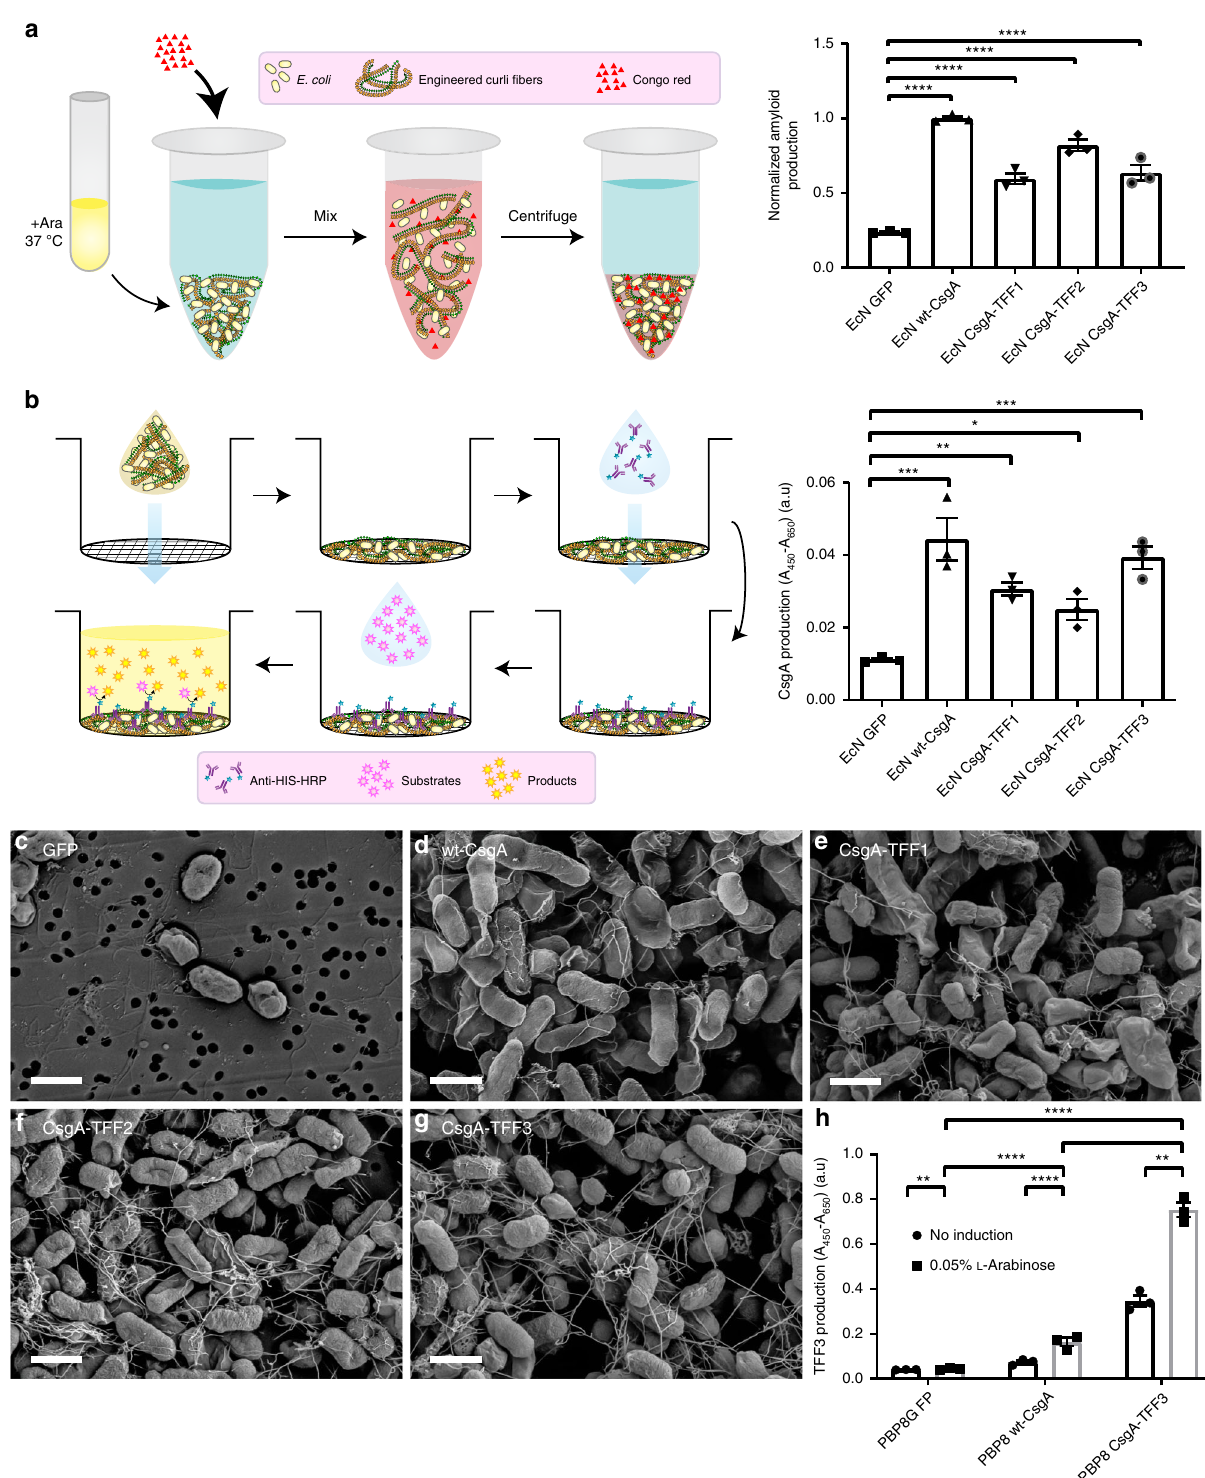
Fig. 2 Production of curli fi ber variants from engineered EcN. a Schematic of quantitative Congo Red (CR)-binding assay (Yellow ovals = E. coli , Orange and green lines = engineered curli fi bers, Red triangles = Congo Red) (left). Normalized amyloid production of each EcN variant, as measured by CR- binding assay (right), after induction with arabinose (Ara) at 37 °C in LB media. b Schematic of whole-cell fi ltration ELISA for the monitoring of modi fi ed curli production from bacterial culture (Purple Y shapes with blue dots = Anti-HIS-HRP, Pink stars = HRP Substrates, Yellow stars = HRP products) (left). Relative CsgA production between EcN variants, derived from anti-6xHis antibody-based detection. c – g Scanning electron micrographs of EcN transformed with plasmids encoding various proteins: c GFP d wt-CsgA e CsgA-TFF1 f CsgA-TFF2 g CsgA-TFF3 (scale bar = 1 μ m). h Relative TFF3 production (using anti-TFF3 antibody) of induced and non-induced PBP8 library. Data are represented as mean ± standard error of the mean (SEM). (ns) p > 0.05, * p ≤ 0.05, ** p ≤ 0.01, *** p ≤ 0.001, **** p ≤ 0.0001, one-way ANOVA followed by Dunnett ’ s test. Source data are provided as a Source Data fi